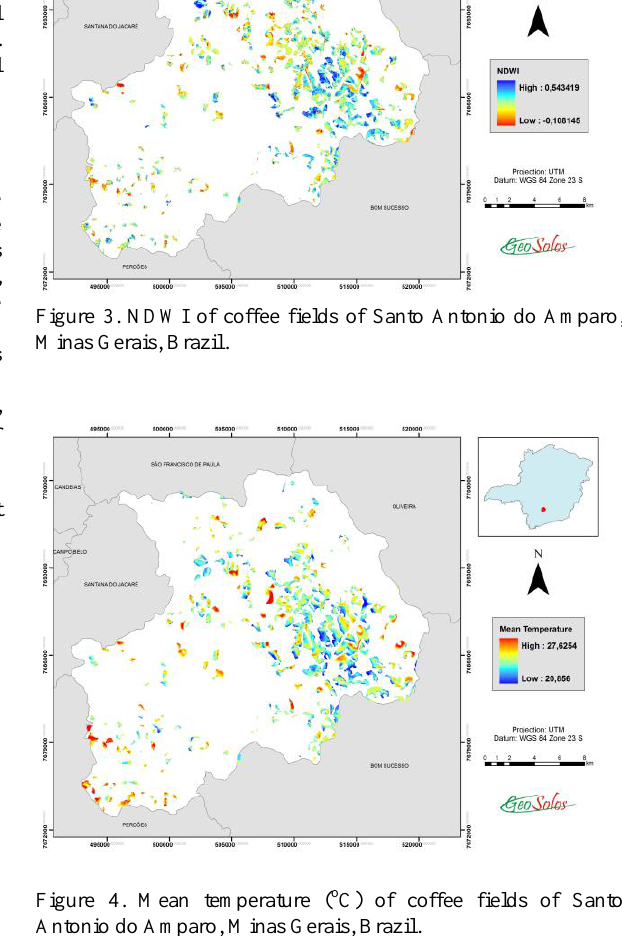
The slope classes (Figure 5) were homogenous throughout the area, with a predominance of undulated (64.4%) and strongly undulated (17.28%). The predominant soil classes were Red- Yellow Latossol (54.08%) followed by Dark-Red Latossol (36.03%). The Red-Yellow Latossol occurs in the central- eastern region of the